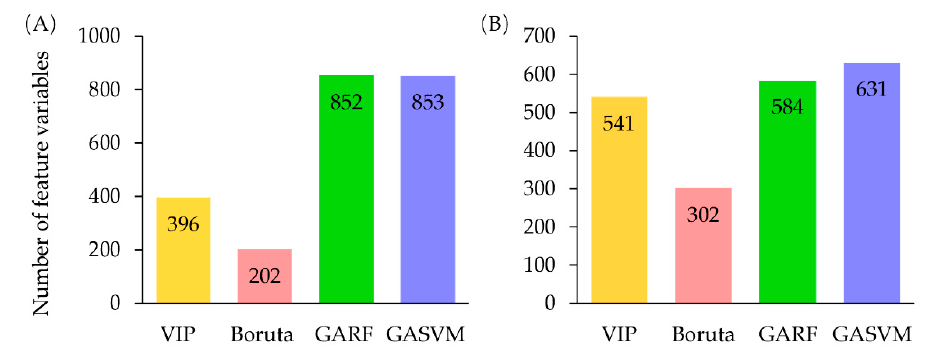
Figure 7. Size of feature variables of the four algorithms ( A ) feature selection of NIR spectroscopy, ( B ) feature selection of FT-MIR spectroscopy.